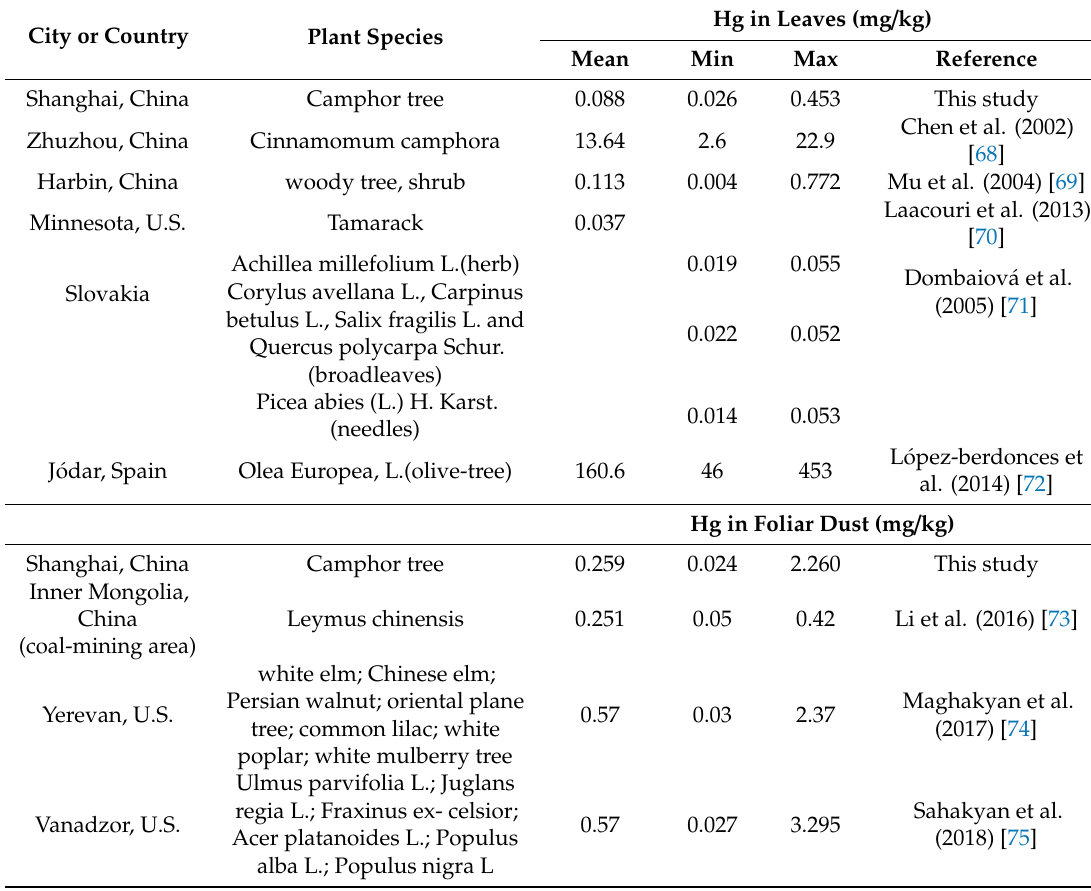
Table 4. Mean, minimum, and maximum concentrations of mercury (mg / kg) in foliar dust and plant leaves in some